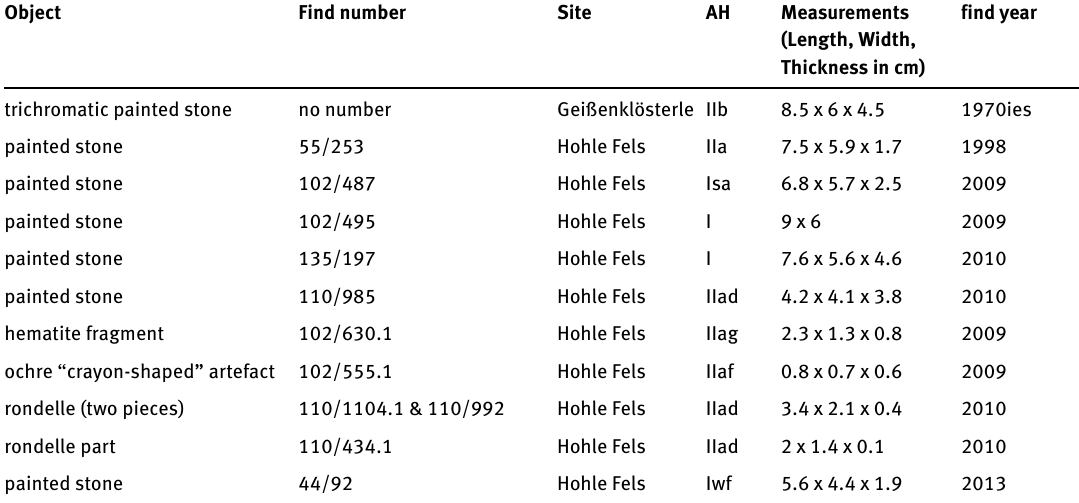
Figure 4. Hohle Fels, painted limestone, excavated 1998. Photo: M. Malina. Table 1. Overview of the painted stones mentioned in the